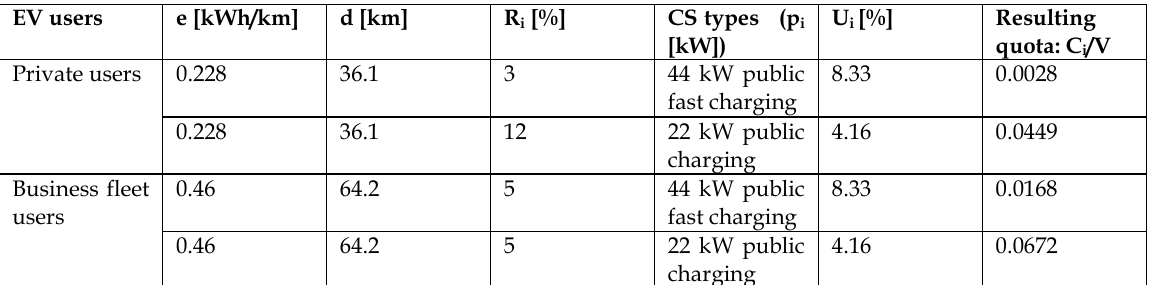
Table 3. Parameters and resulting quotas used for different EV users and public CS types in the “higher